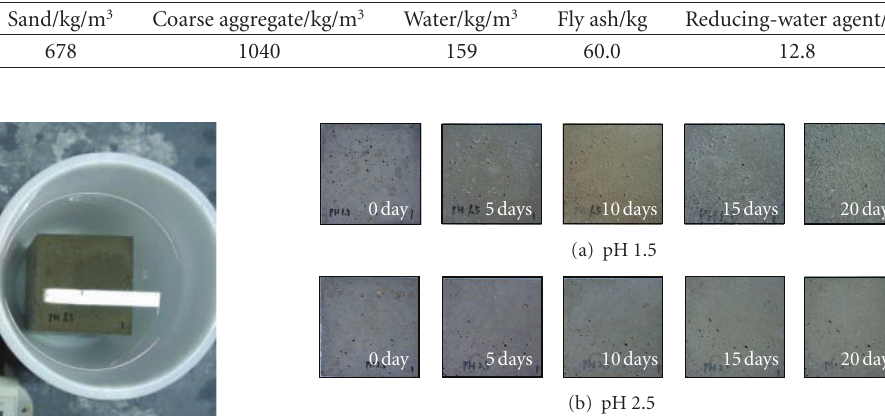
Figure 2: The change of surface appearance on concrete specimens exposed to acidic